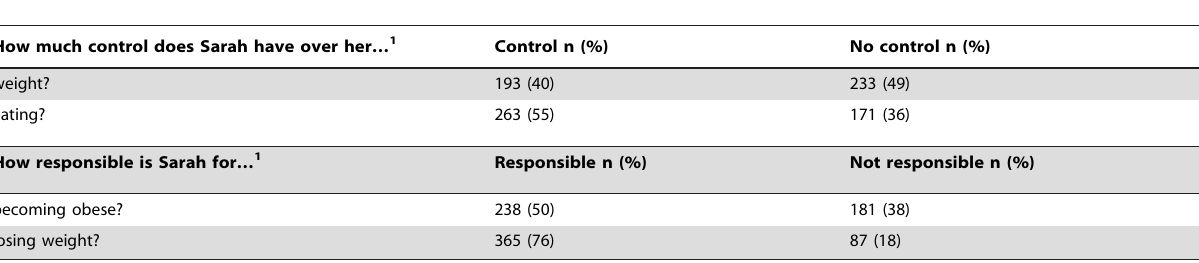
Table 2. Responses to control and responsibility based on